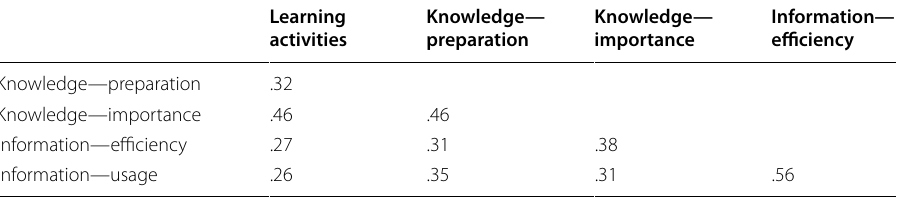
All correlation coefficients are significant at p < .001